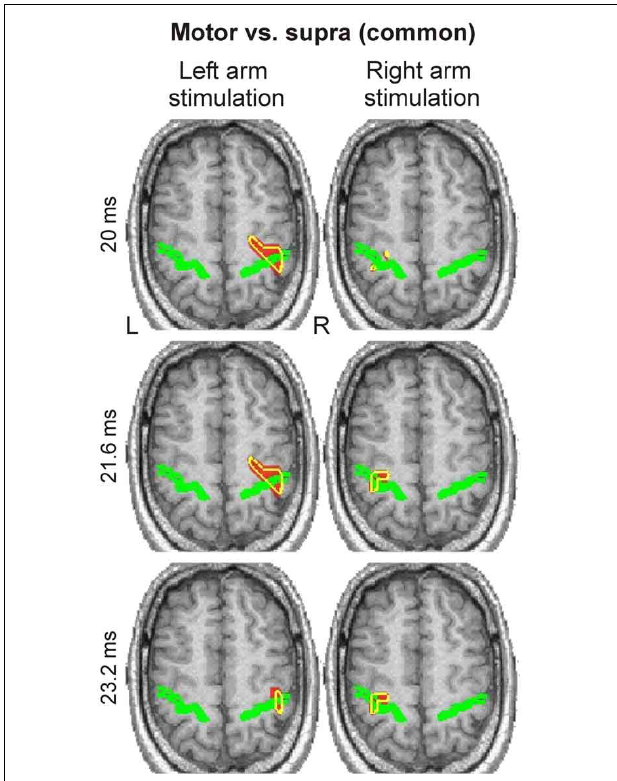
FIGURE 4 | Spatio-temporal grand activation maps derived from “Motor vs. Supra” contrast are shown for left (left column) and right (right column) arm stimulation at three latencies (indicated at the left side of each row). The common across all three subjects activations are projected on the MRI of the blind subject. The axial slice of MRI best covering the central sulcus, indicated by a green outline, is shown. Yellow contours encompass regions with statistically significant ( P < 0 . 0001) increases in activity in all three subjects.